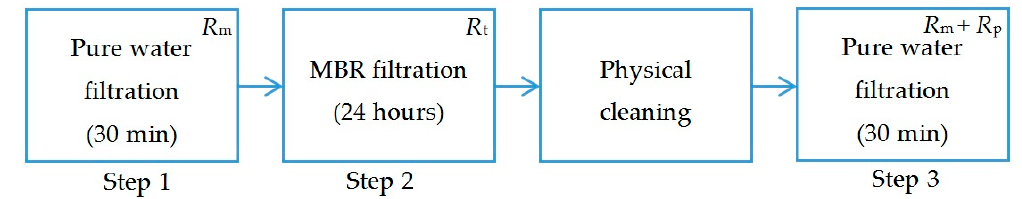
Figure 1. Flow diagram of the experimental procedure.